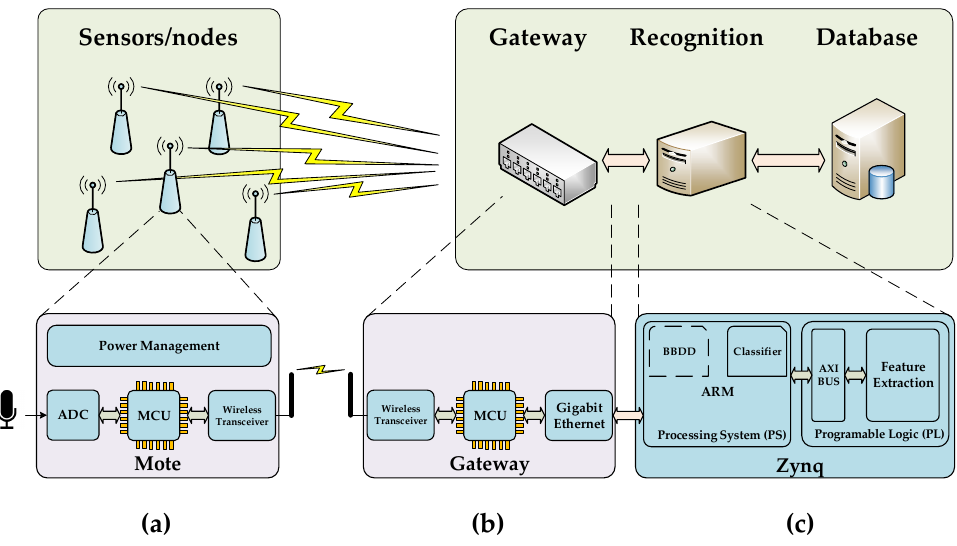
Figure 2. System proposal detailed where the three basic elements are presented: ( a ) node; ( b ) gateway; and ( c ) Field Programmable Gate Array (FPGA)-based centralized computing platform based on a Zynq.